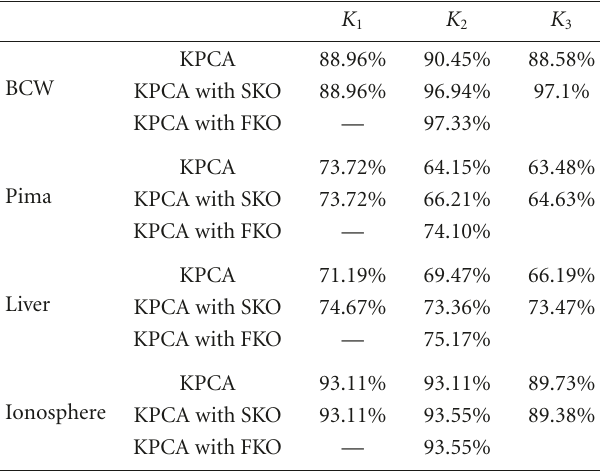
Table 1: The comparison of recognition rates of di ff erent methods in di ff erent experiments. K 1 , K 2 , and K 3 , respectively, correspond to Gaussian, polynomial, and linear kernels.